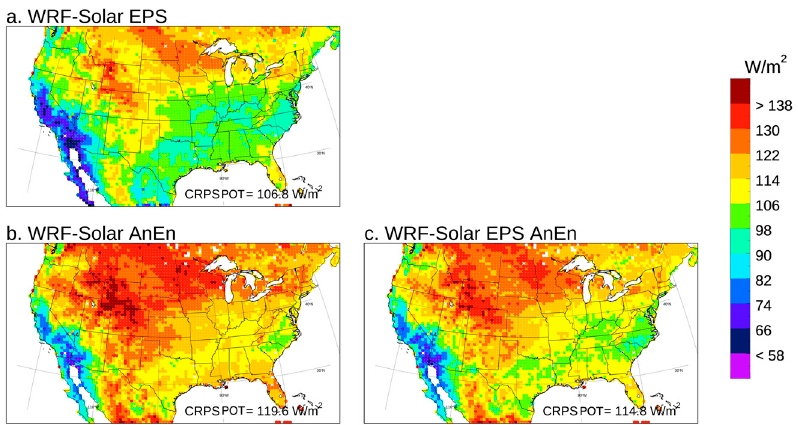
Figure A6. Continuous ranked probability score (CRPS) map computed for DNI by pooling runs and the forecast lead times from +24 to +48 h for 2018 together.